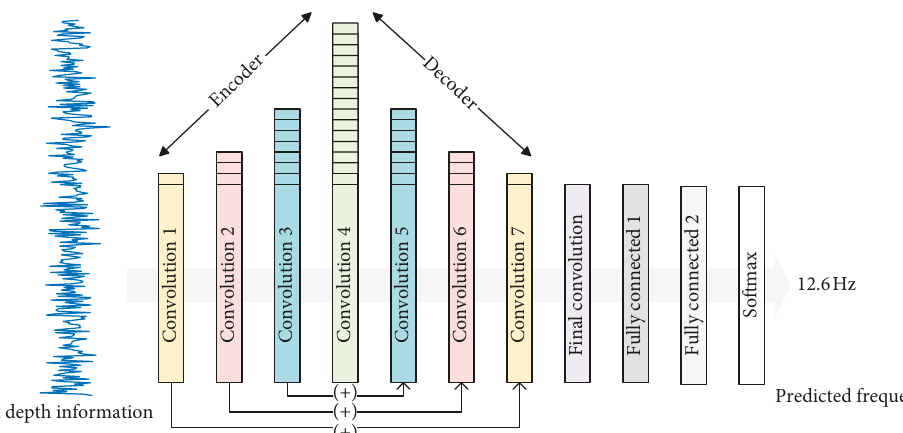
Figure 2: Proposed artificial neural network world depth variation signals under a specific vibration frequency. An algorithm was used as the simulation signal